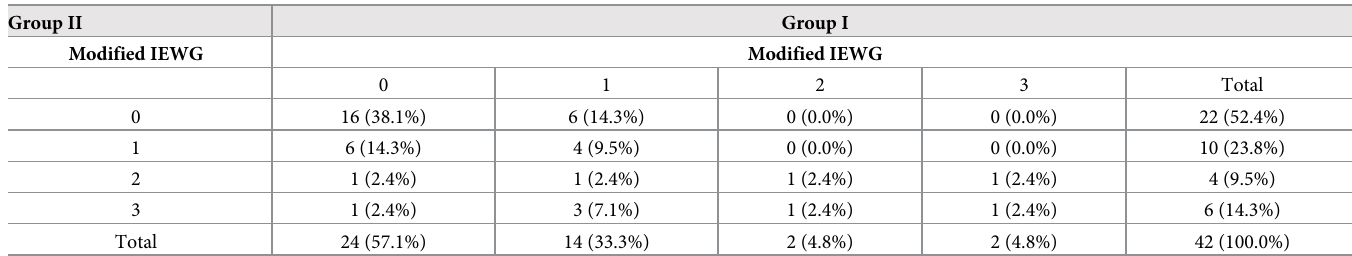
Table 4. Contingency table for variable “modified IEWG”grouped by Group I &